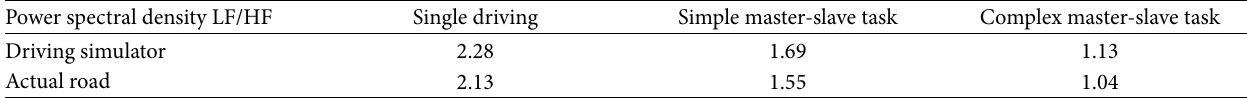
Table 7: Comparison of night power spectral density LF/HF parameter results (actual road vs. driving simulator). Power spectral density